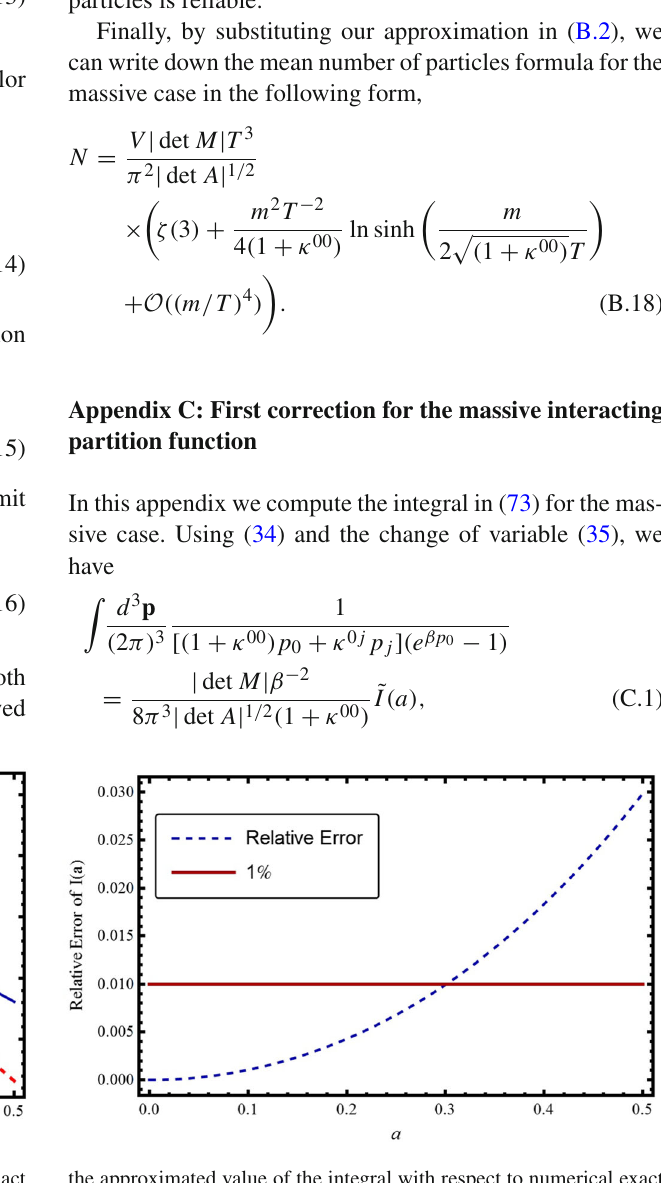
the approximated value of the integral with respect to numerical exact value. The horizontal continuous (red) line corresponds to an error